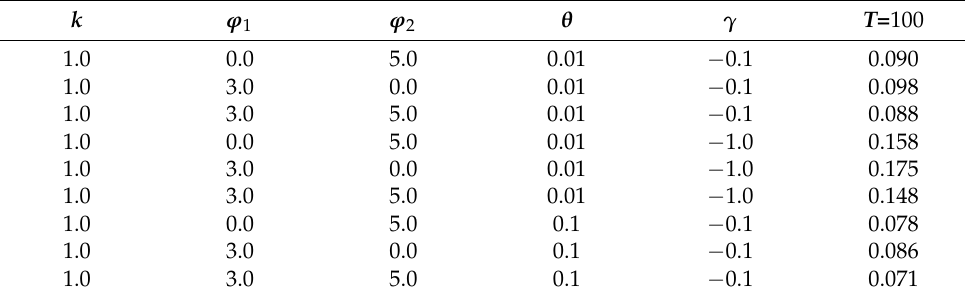
Table 3. The over filtration of the Fourier transforms under the FKSS-DGP.